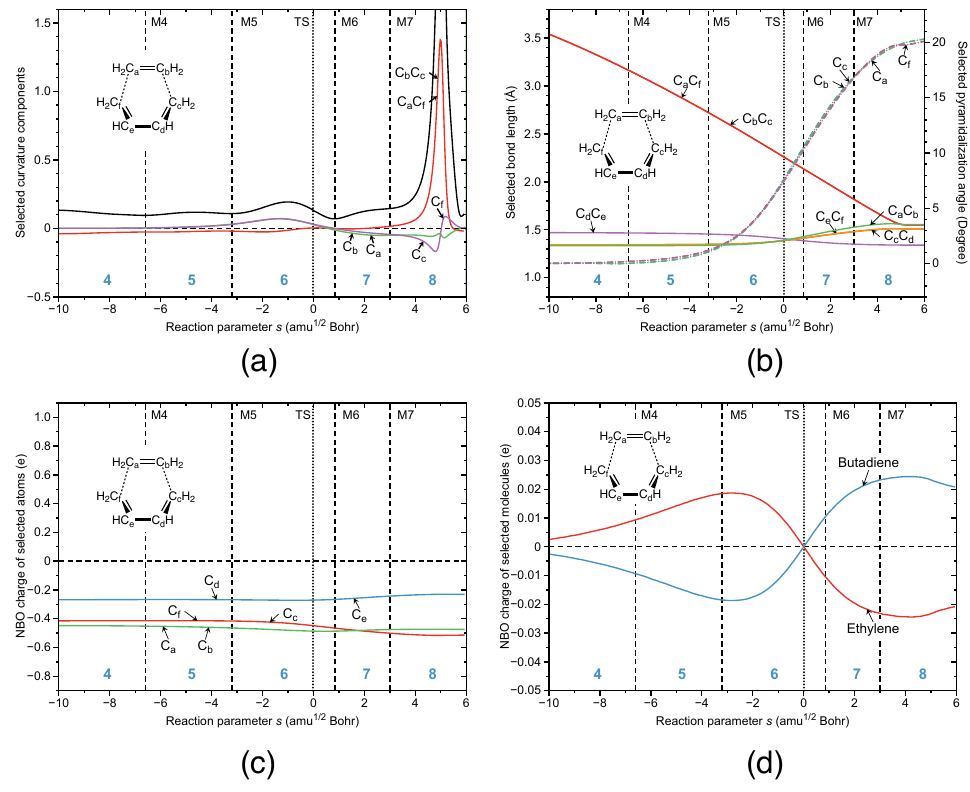
Figure 3. Reaction properties along the reaction path for the parent DA reaction; ( a ) decomposition of the reaction curvature into selected components: the bonds shown as two character labels, and the pyramidalization angles shown as a one character label; ( b ) change of the selected geometrical parameters: the bonds shown as two character labels, and the pyramidalization angles shown as a one character label; ( c ) change of the NBO charges of the selected atoms; ( d ) change of the NBO charges of the selected molecules. B3LYP/6-31G(d,p) level of